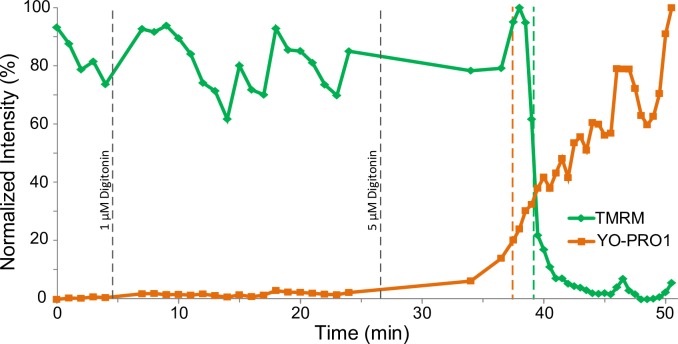
Mutual dynamics of cell-averaged FTMRM loss and FYO-PRO1 gain in a cell from a heart subjected to titration by the membrane detergent digitonin (the Digi group).The FTMRM loss (indicator of MPT) and FYO-PRO1 gain (indicator of SP) overlap in time, reminiscent of cell transitions occurring during reperfusion in the absence (see Fig 1) and the presence (see Fig 2) of CsA.